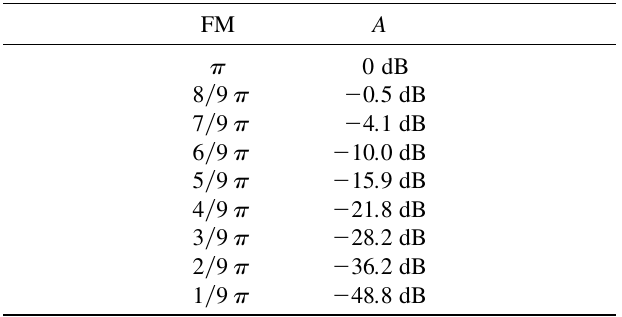
TABLE III. List of the FM peak levels A for a continuous single cavity control with unity gain (values from Fig.